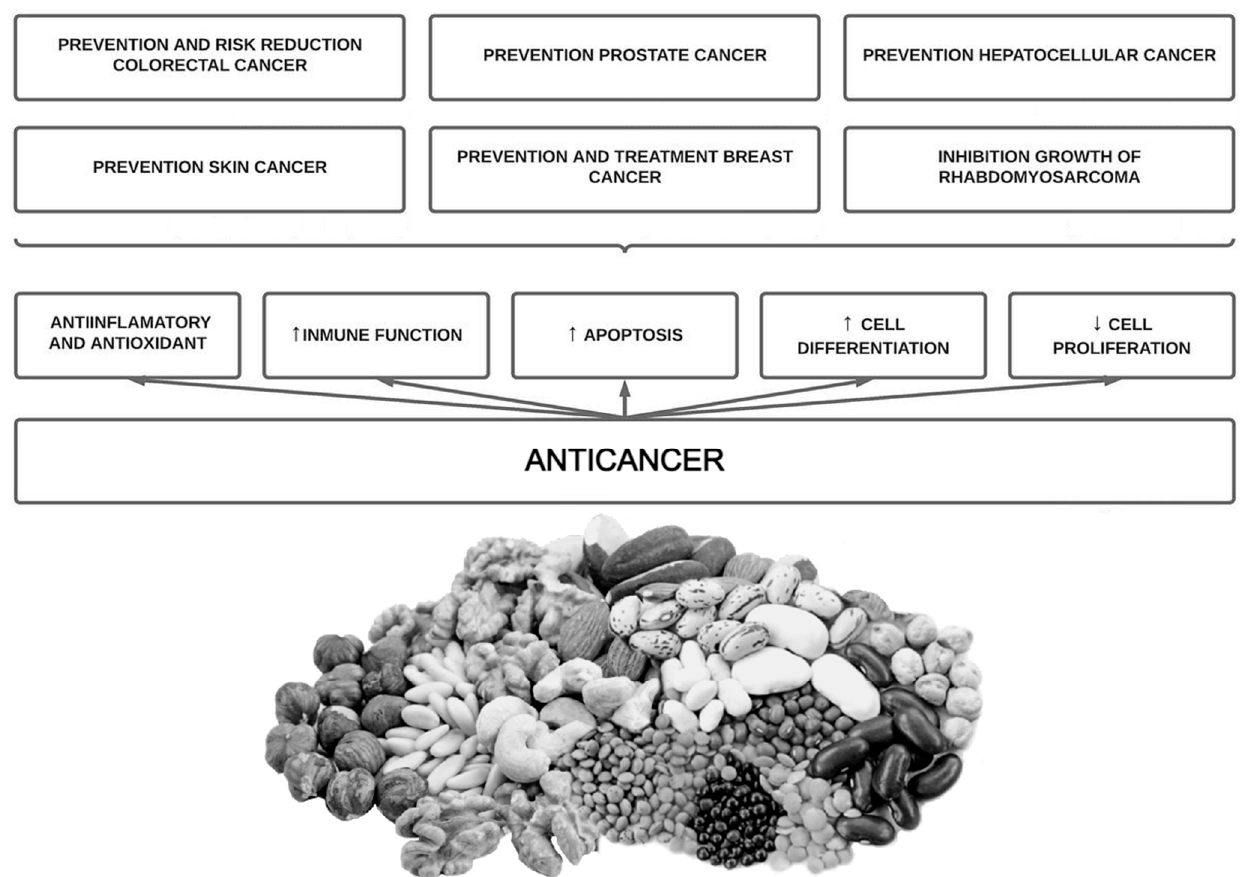
Figure 3. Overview of potential beneficial bioactivities of phytate on cancer.